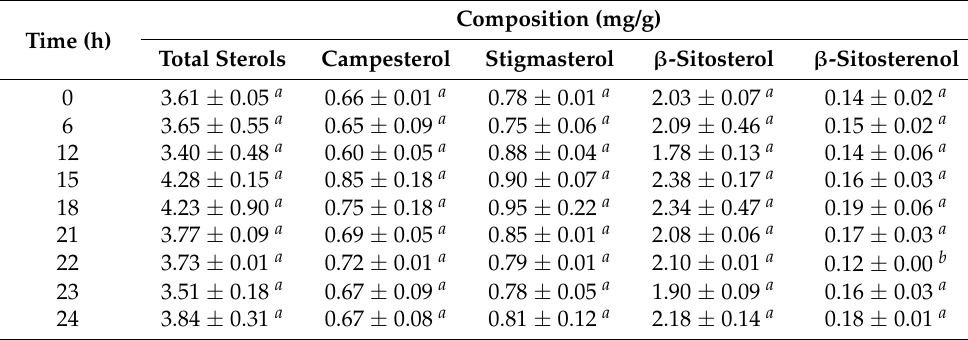
Table 2. The phytosterols composition of the soybean oils pretreated by visible light exposure prior to activated clay